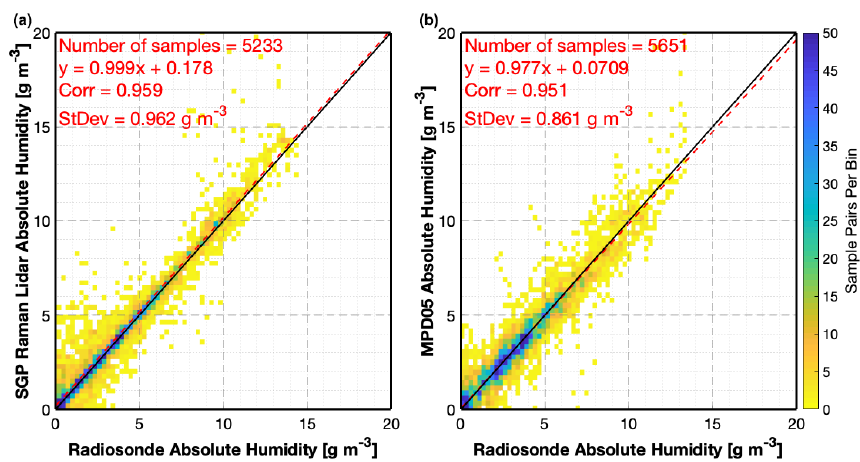
Figure 3. Frequency histograms showing the correlation between the SGP Raman lidar (a) and Gen 4 MPD05 (b) with 77 collocated radiosondes between 19 April and 1 May 2019. The colors indicate the number of sample pairs per bin, with 0 . 1 × 0 . 1gm − 3 bin sizes. The correlation between Raman lidar and radiosondes is expected to be near 1 as the lidar is calibrated from the same sondes while the MPD retrievals are run independent of the radiosonde